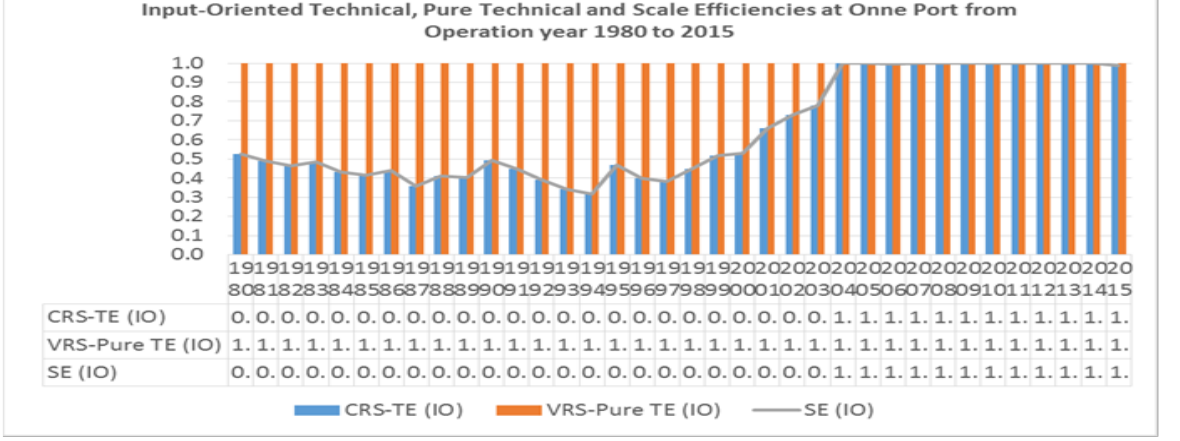
Figure 9: CRS – Technical Efficiency (Input-oriented) and CRS – Scale Efficiency (Input-oriented) at Onne Port Complex from 1980 – 2015